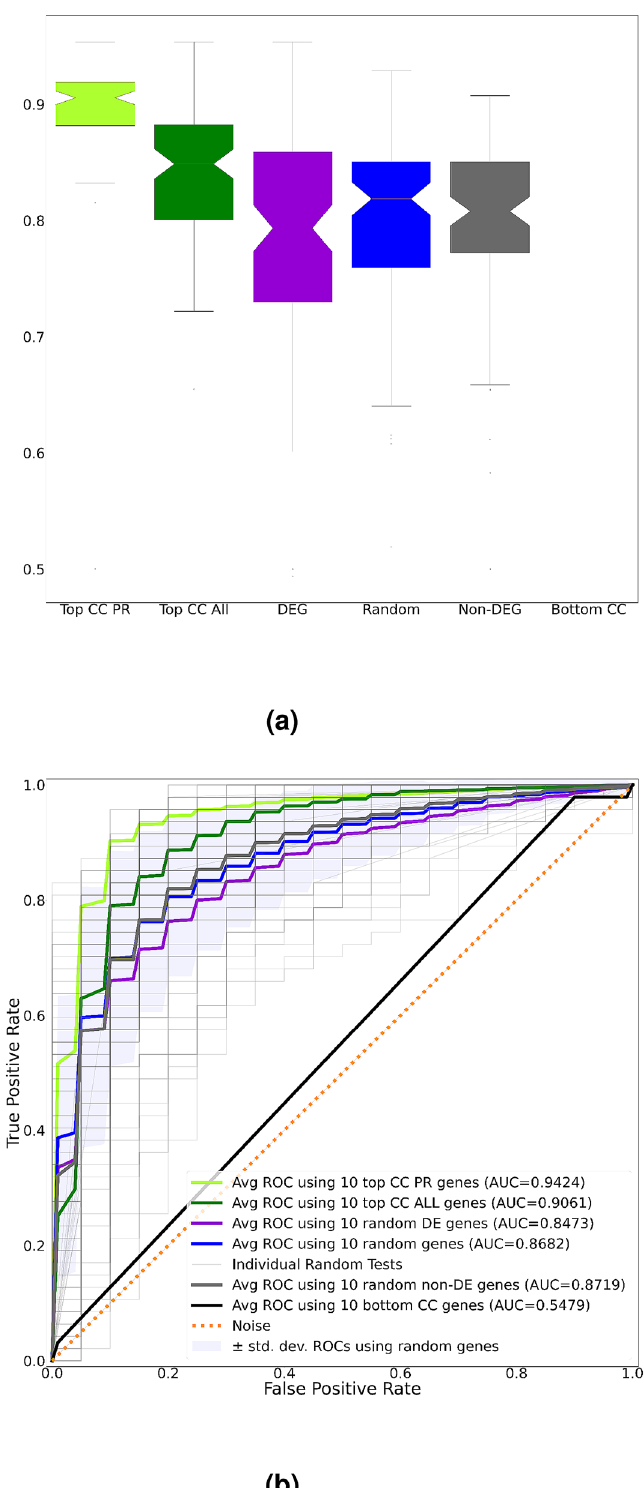
Figure 9. ( a ) From left to right, balanced accuracies of the evaluation classifier using a randomly selected set of the most relevant 10 Top CC PR, 10 Top CC ALL Biomarkers (out of top 40), randomly selected 10 DE genes (DEG), any randomly selected 10 genes (random), randomly selected 10 non-DE genes (non-DEG) and the least relevant 10 cross-cancer biomarkers (bottom CC). Reported results are across 100 independent runs of respective gene subset selections. Note that, CC biomarkers still outperform other gene subset selections. ( b ) The ROC Curves of different gene subset